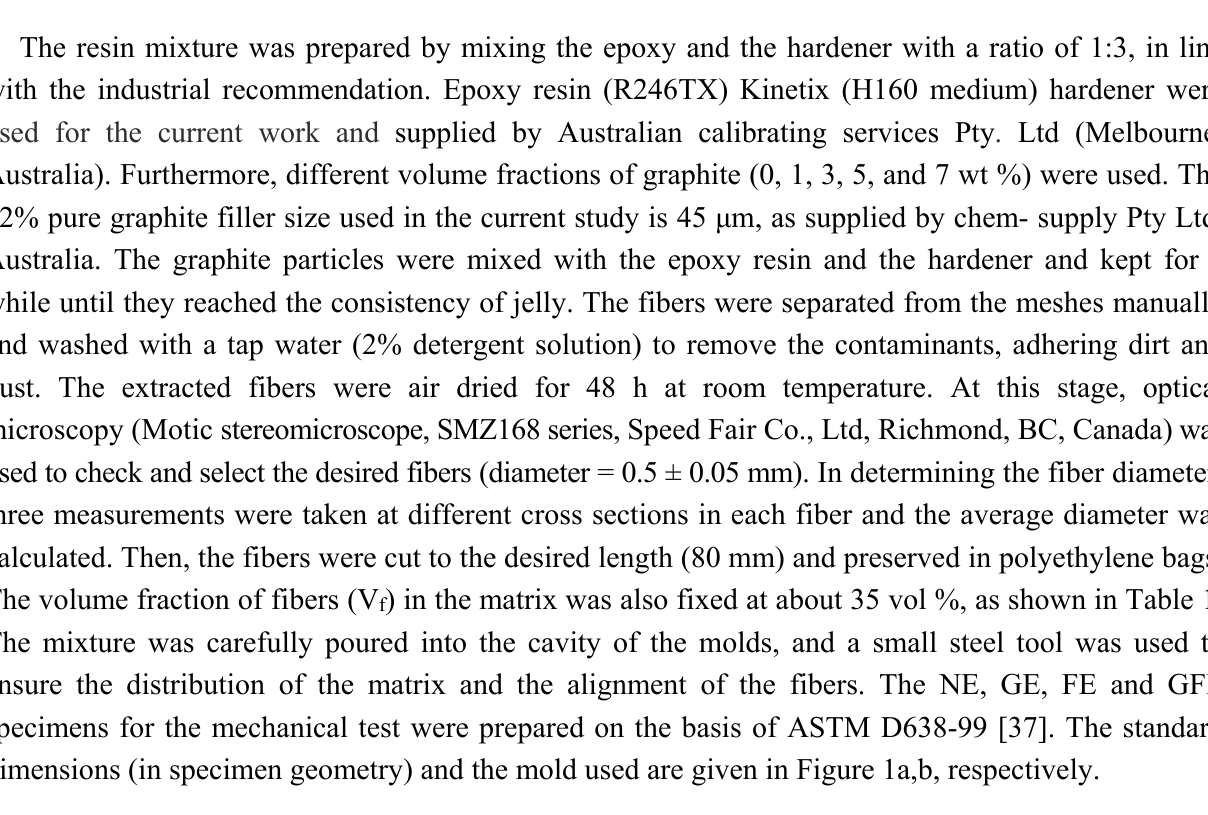
Table 1. Designation of the fillers/epoxy